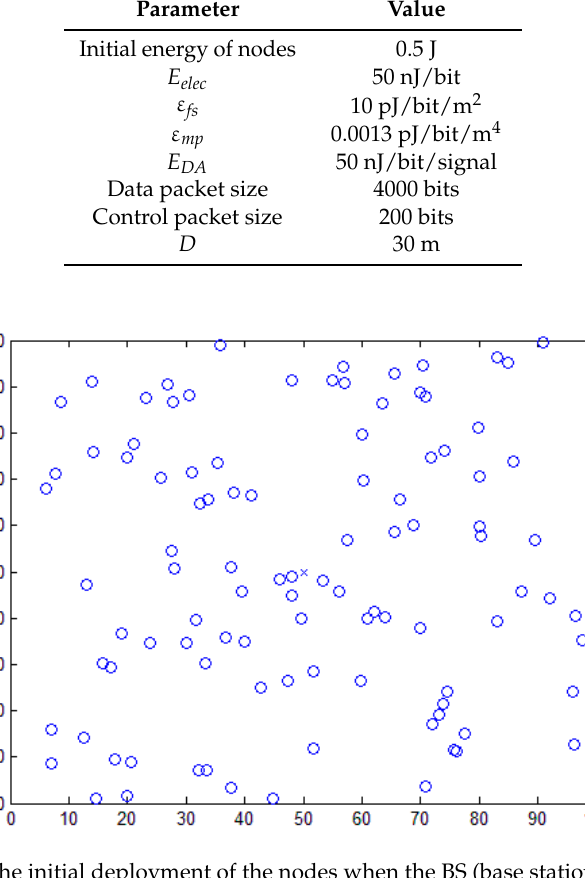
Figure 3. The initial deployment of the nodes when the BS (base station) is inside.